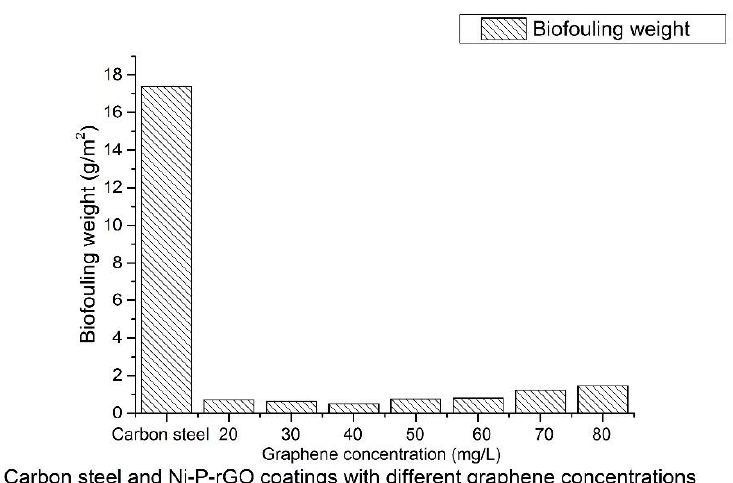
Figure 3. Macrographs and micrographs of the carbon steel surface and of the coating surface after experiments.